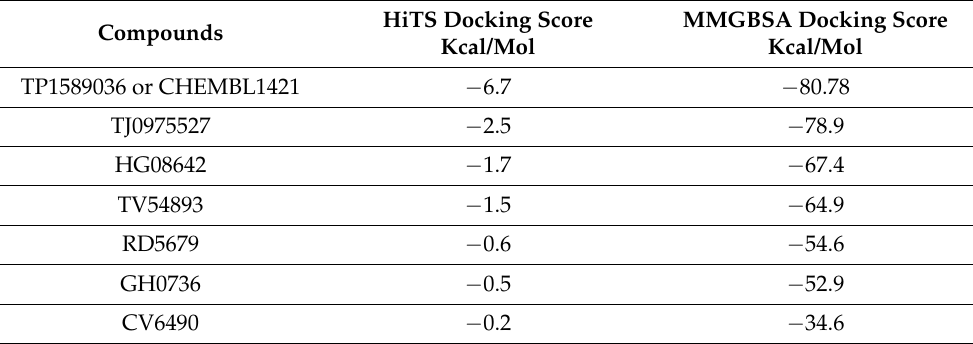
Table 2. Comparative docking scores of compounds with targeted protein from HiTS database and MMGBSA method.